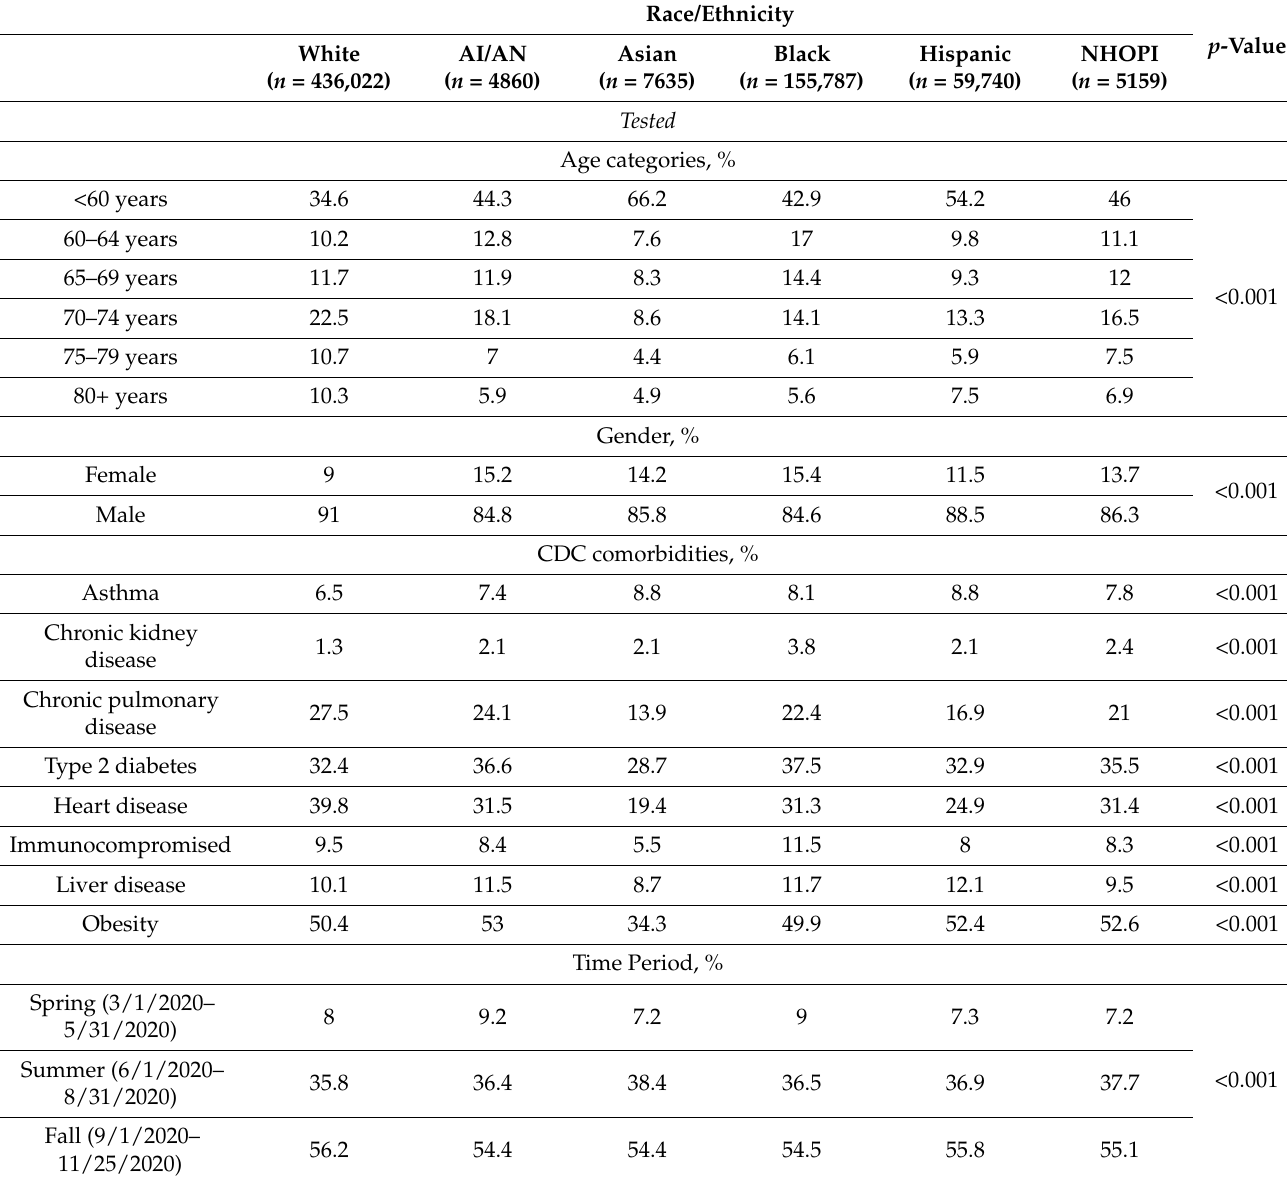
Table 2. Sample characteristics of veterans who received a COVID-19 test and tested positive, stratified by race/ethnicity.